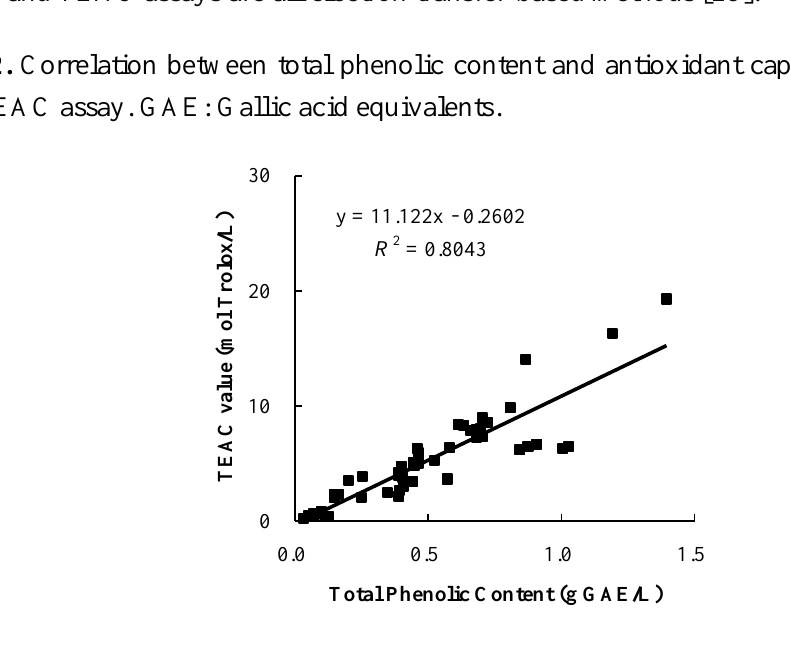
Figure 3. Correlation between total antioxidant capacities measured by the FRAP and TEAC